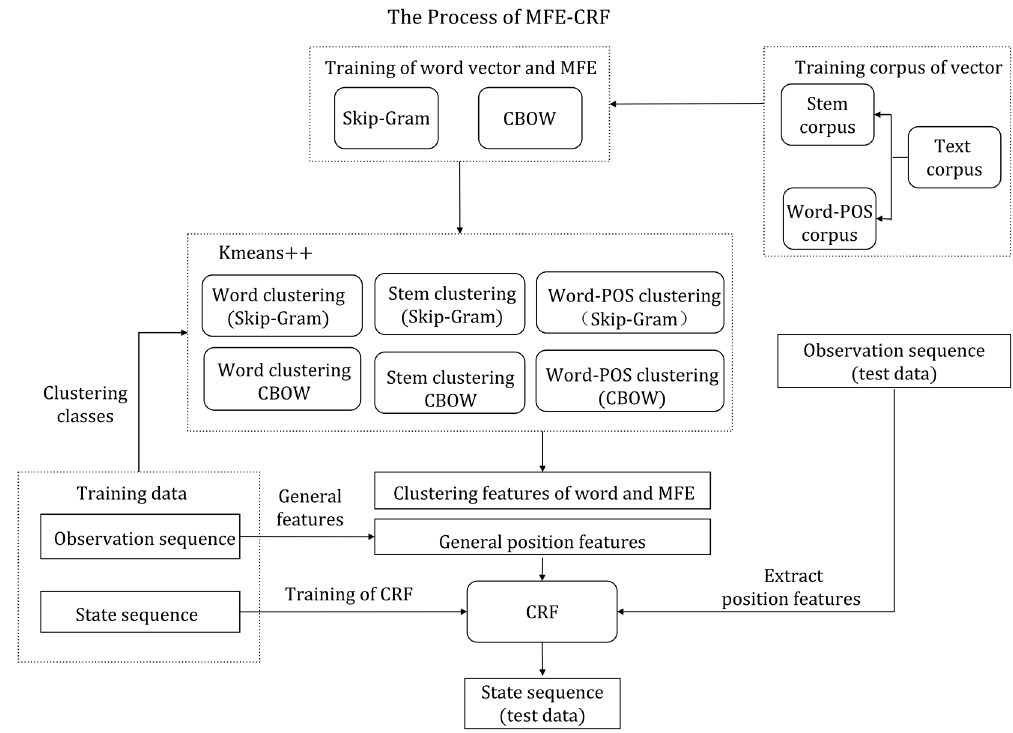
Figure 2. The process of MFE-Conditional Random Field (CRF).